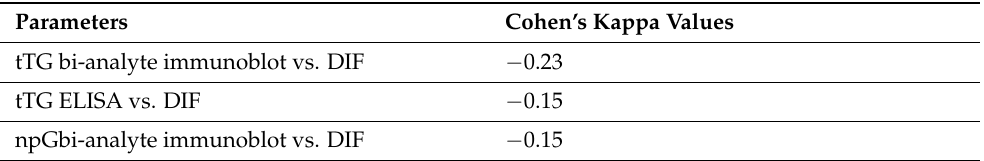
Table 5. Interrater agreements (Cohen’s kappa values) among examined immunoserological systems for the antibodies tested and